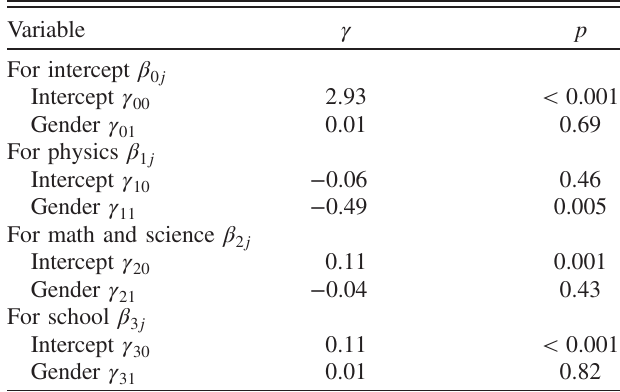
TABLE II. Students ’ self-efficacy states.